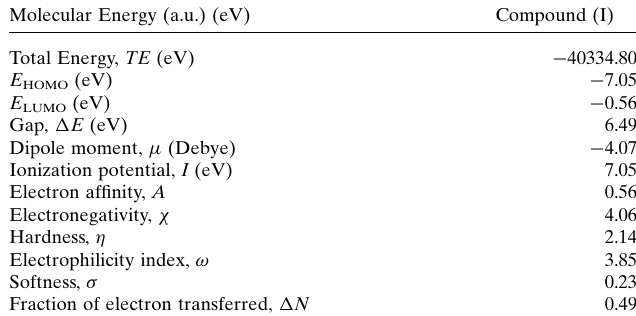
Table 3 Calculated energies.